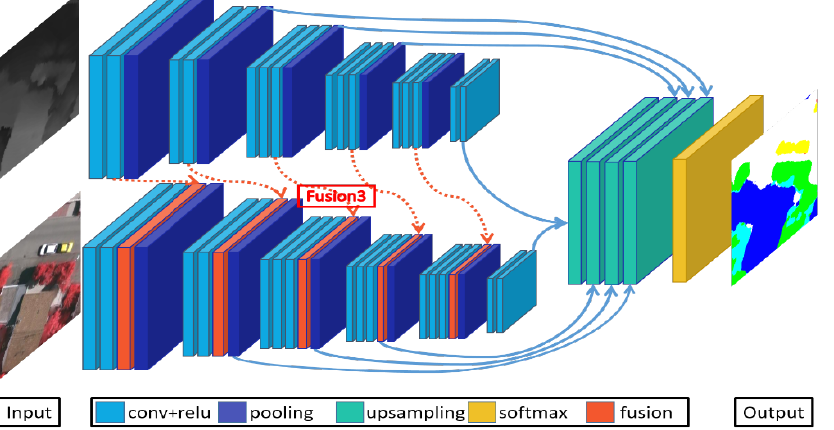
Figure 2. Fusion model incorporating heterogeneous remote sensing data: infrared imagery and